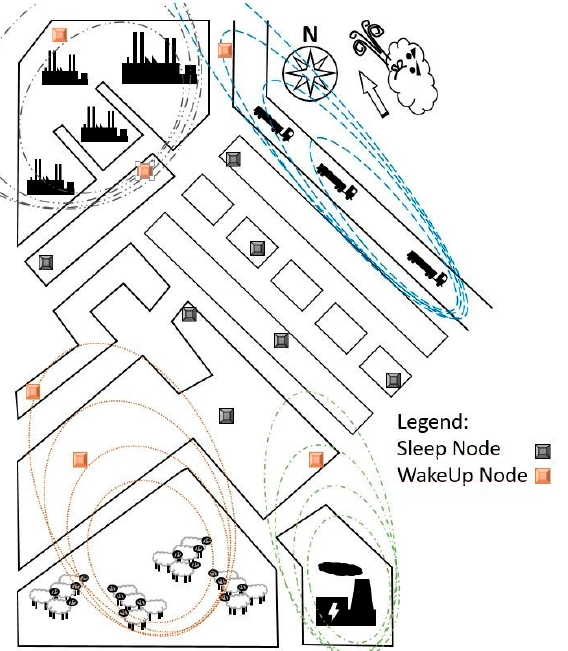
Figure 1. Schematic drawing of a possible deployment of the odor sensor network: Upon waking up the respective sensor node starts to determine the hydrogen sulphide concentration, which is a very good indicator for the odor level. Taking into account ambient weather conditions and information from the distributed sensor network it is possible to infer the source of the bad